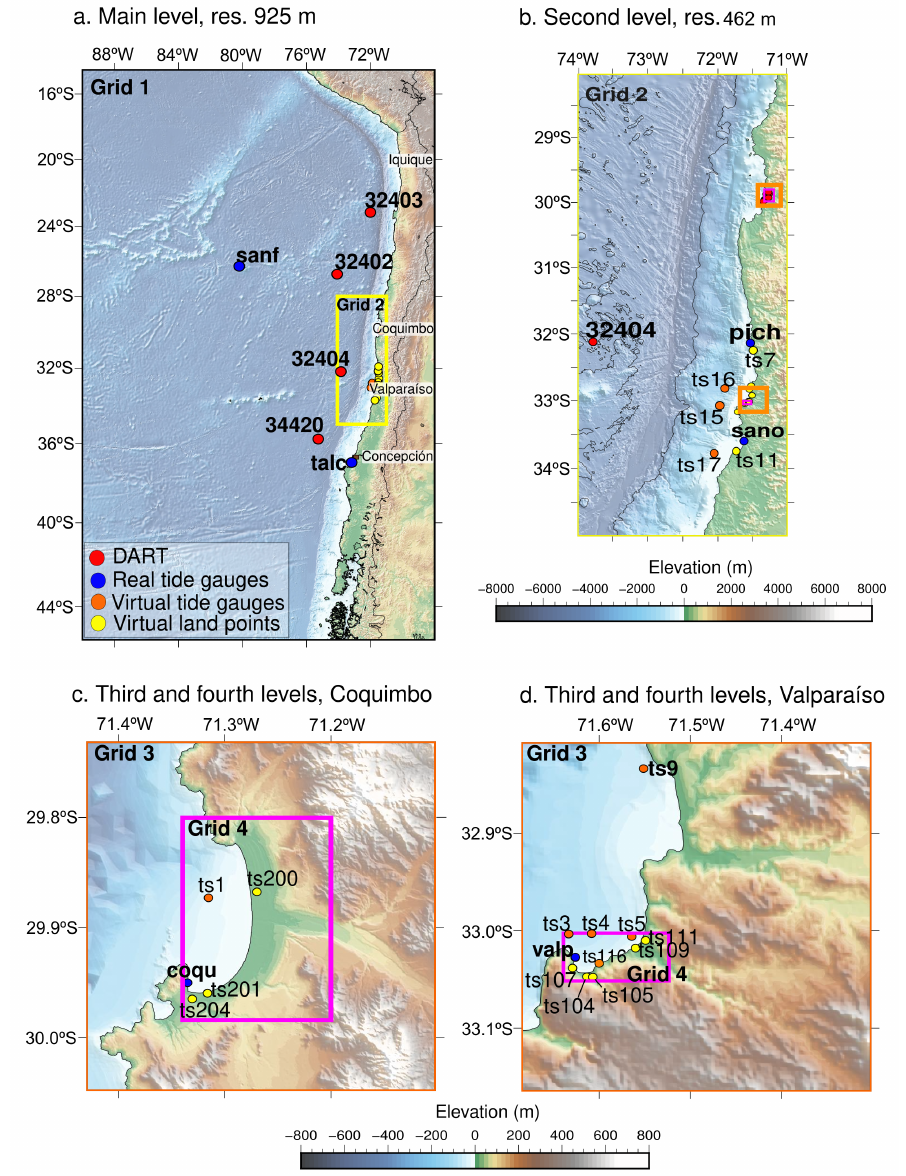
Figure 1. Bathymetry domains used for the simulations with Tsunami-HySEA and COMCOT. ( a ). Largest domain (grid level 1), where mostly DART and tide gauges are shown in bold. Red circles stand for Deep-ocean Assessment and Reporting of Tsunamis (DART), blue circles refer to real tide gauges, and the orange and yellow circles show virtual offshore and inland gauges, respectively. ( b ). Second level of the nested grids. ( c ). Third and fourth levels of the nested grids are shown for the Coquimbo set-up. ( d ). Third and fourth levels of the nested grids are shown for the Valparaíso